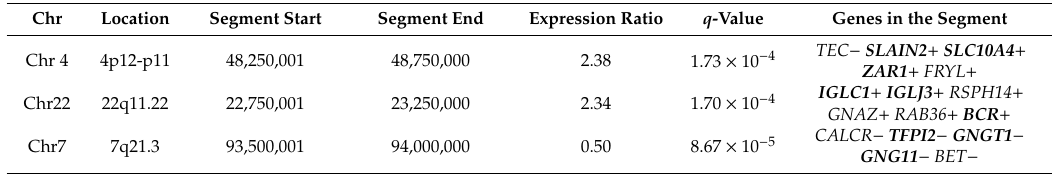
Table 2. Chromosomal segments statistically significant in TRAM “Map” mode analysis of male vs. female hMSCs derived from adipose tissue (hADSCs)